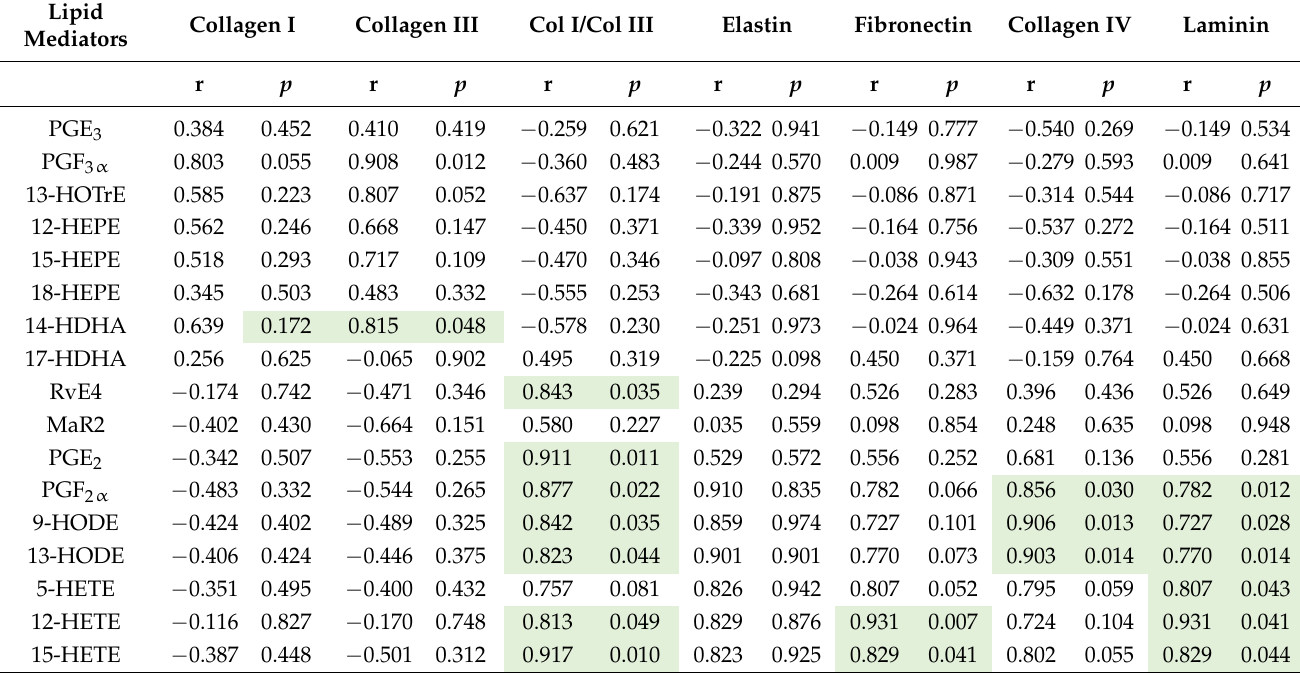
Table 2. Linear regression comparing ECM protein levels to the lipid mediator